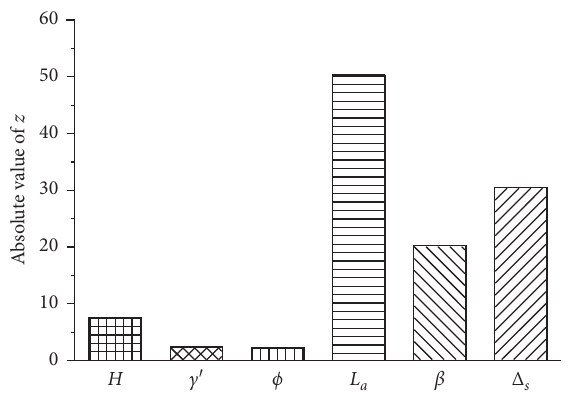
Figure 9: Summary of absolute values of z